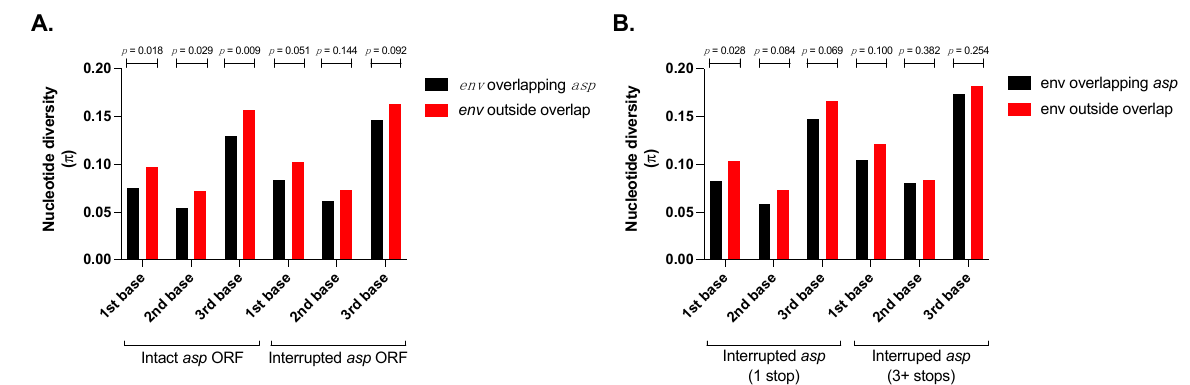
Figure 1. The nucleotide diversity of the env gene in the region of overlap with the asp ORF compared to the region of non-overlap. We assembled a dataset of 3725 env sequences that overlap an ‘intact’ asp ORF, defined as containing start and stop codons at canonical positions and lacking internal stop codons. We also assembled a set of 1735 env sequences that overlap an ‘interrupted’ asp ORF, defined as containing start and stop codons at canonical positions but containing one or more internal stop codons. All the sequences are derived from HIV-1 strains belonging to group M, except for one, which is from the SIVcpz strain MB66 (NCBI acc. number DQ373063). The env sequences from each strain were subdivided into a region of overlap with the asp ORF (env overlapping asp, black bars), and a region of non-overlap with asp (env outside overlap, red bars). The latter does not include the env sequences that overlap with vpu and tat/rev. We found that the nucleotide diversity ( π ) in the first, second, and third base of each codon in the env region of overlap with asp were significantly lower than the ones in the region of non-overlap in the case of env sequences overlapping ‘intact’ asp ( p = 0.018, p = 0.027, and p = 0.009, respectively; Student’s t -test), but not in the case of env sequences that were overlapping ‘interrupted’ asp ( p = 0.051, p = 0.144, and p = 0.092, respectively; Student’s t -test) (panel A ). From the 1735 env sequences that were overlapping ‘interrupted’ asp ORF, we extracted a subset of 1231 sequences with one internal stop codon in asp, and a subset of 119 sequences with three or more internal stop codons in asp. We found that the nucleotide diversity ( π ) in in the env region of overlap with asp was significantly different compared to the region outside the overlap only in first base of the 1231 sequences with one stop codon in asp ( p = 0.028, Student’s t -test), while all the other comparisons were not significantly different (panel B